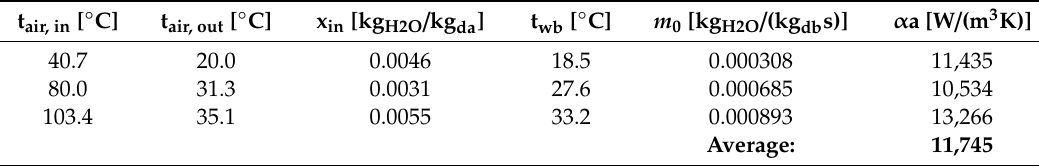
Table 4. The calculated values for the term α a for the bed height of 300 mm. Bulk density of mixture 116 kg db / m 3 and air velocity 0.75 m / s in all